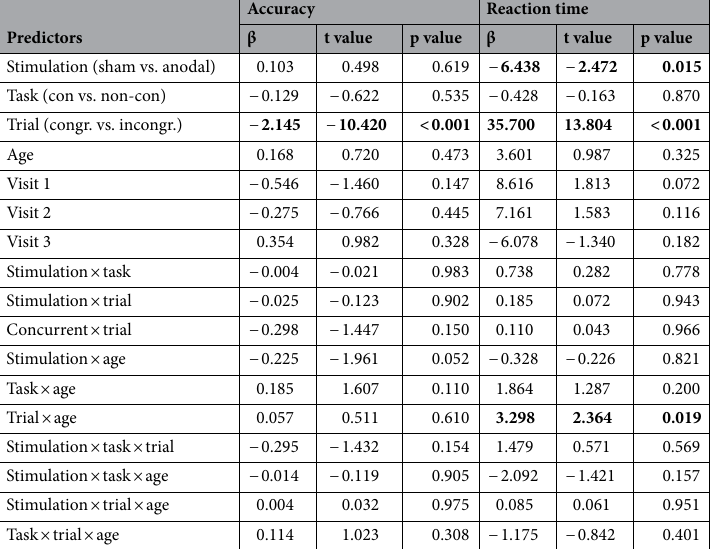
Table 4. Coefficients and corresponding t values and p values for Flanker accuracy and reaction time. Significant results are printed in bold.